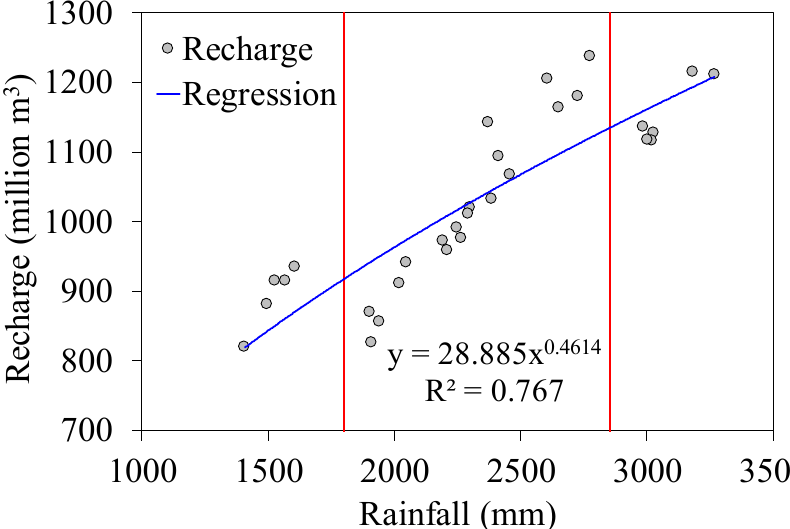
Figure 8. Relationship between groundwater recharge and rainfall in the Choushui River alluvial fan.